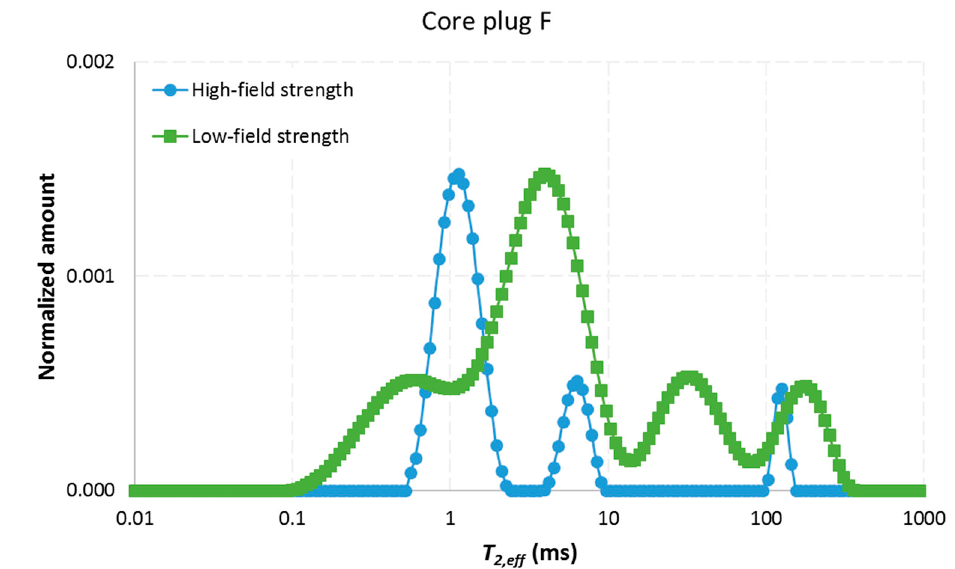
Figure 12. Transverse relaxation distribution for core plug F obtained by the CPMG sequence at high-field strength, B 0 = 4.70 T, and low-field strength, B 0 = 0.28 T. The low-field distribution is normalized with respect to the bulk water distribution, and the sum of the data points is a measure of the porosity of the core plug. The high-field distribution is scaled to the amplitude of the low-field distribution.